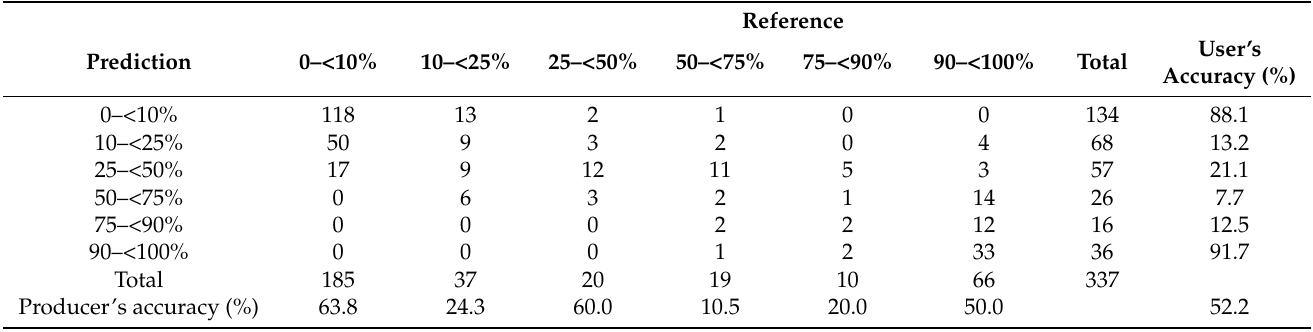
Table A11. Confusion matrix for Southwest model predicting IA BA change with Sentinel-2 dNBR with